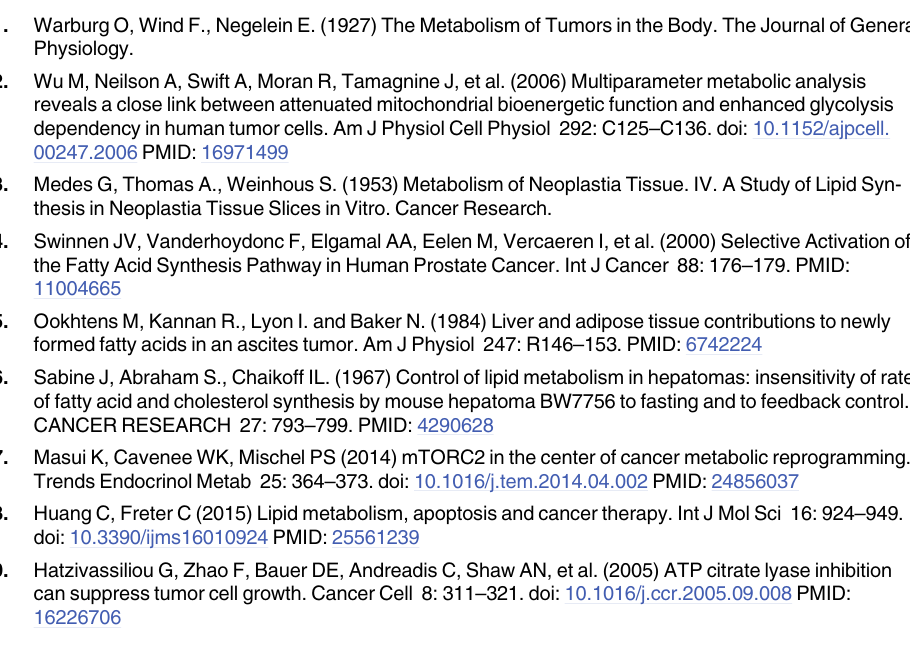
S2 Table. Comparison of amino acids composition in DMEM and Seahorse media. S3 Table. Taqman probes used for qPCR analyses. S4 Table. A: Antibodies used for western blot analyses . B: siRNAs used for knockdown experiments . S5 Table. Summary of OCR values from bioenergetics experiment after 144 hours treat- ment with 30 μM ACCi or DMSO